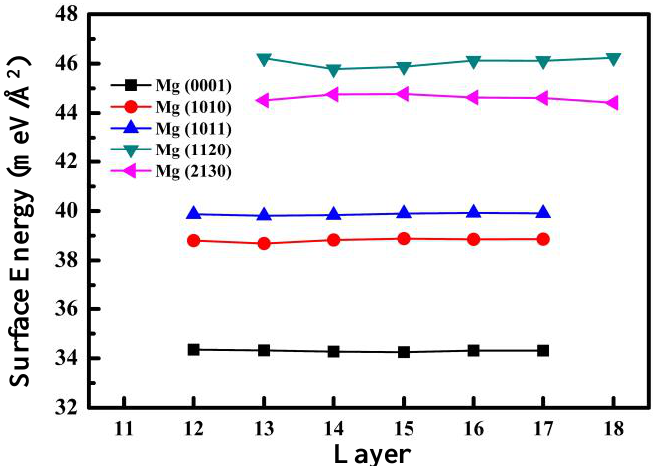
Figure 2. Surface energies of Mg basal (0001), prismatic (10 1 0), (11 2 0), (21 3 0) and pyramidal (10 1 1) surfaces.